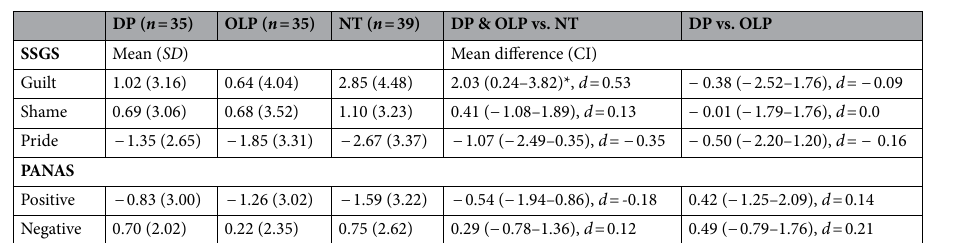
DP ( n = 35) OLP ( n = 35) NT ( n =